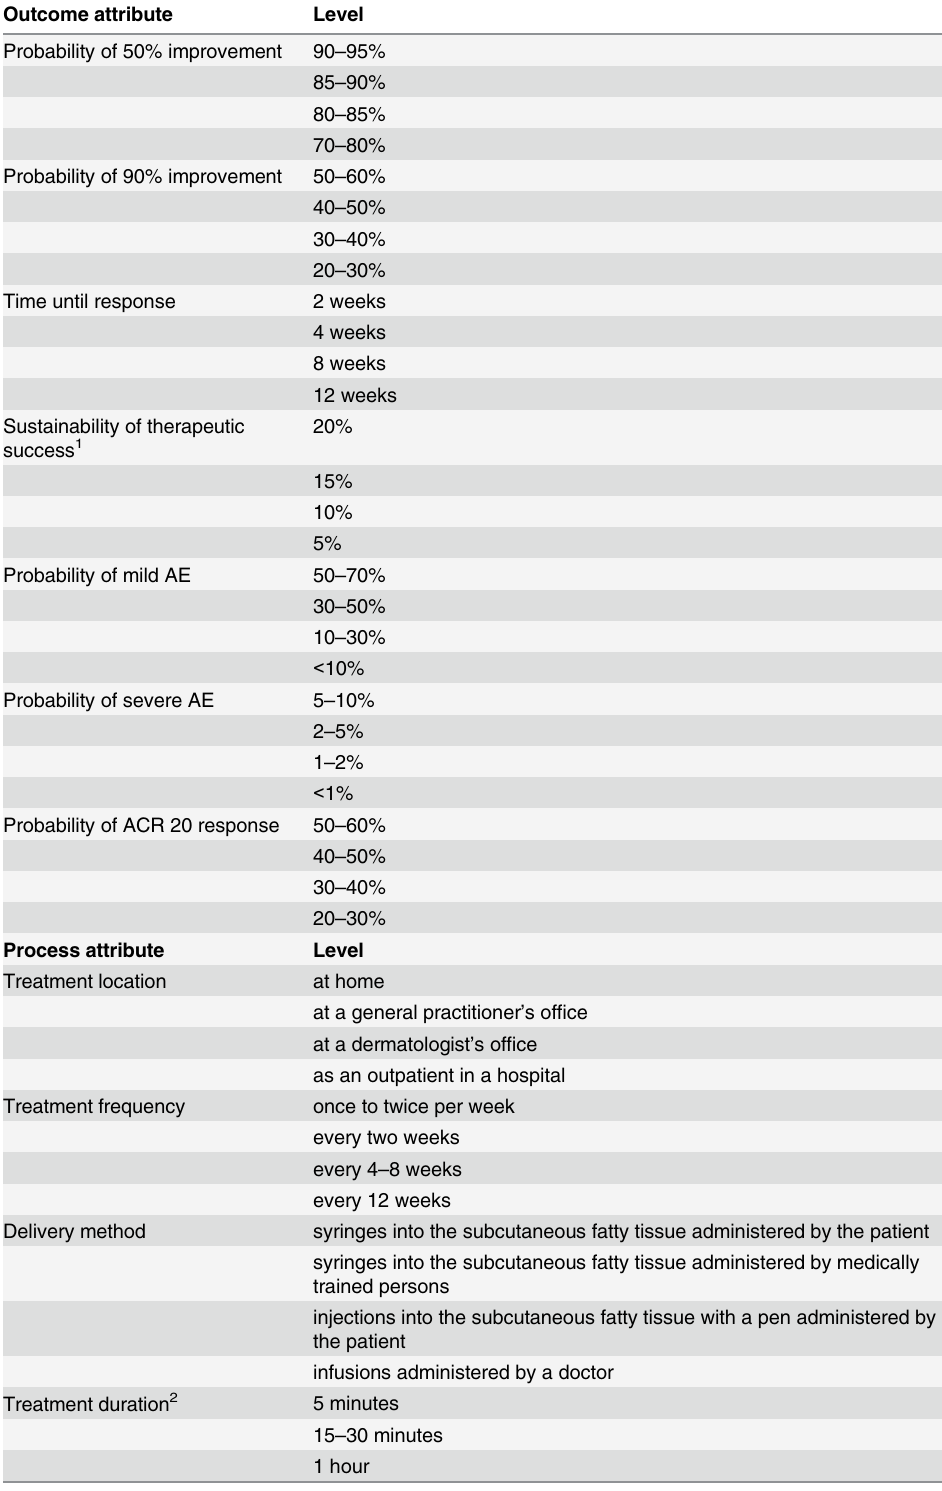
Table 1. Outcome and process attributes and attribute levels used in the conjoint